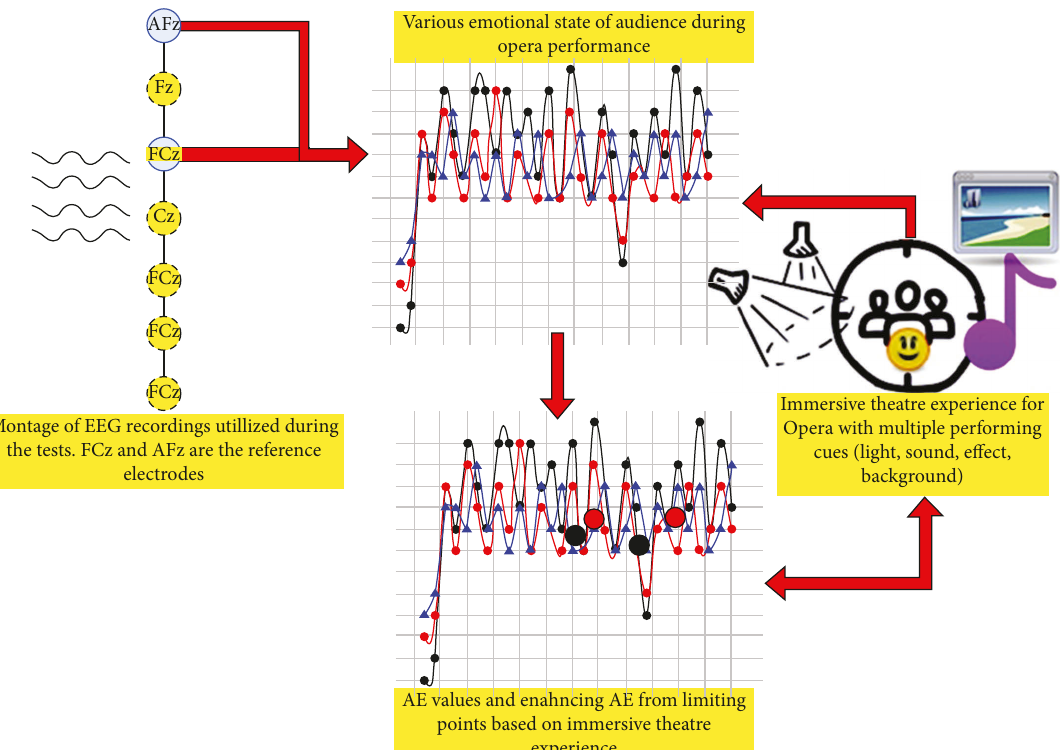
Figure 3: Acquiring EEG recordings through electrodes, emotion detection, and enhancing AE through immersive theatre experience (EEG montage image has been acquired from